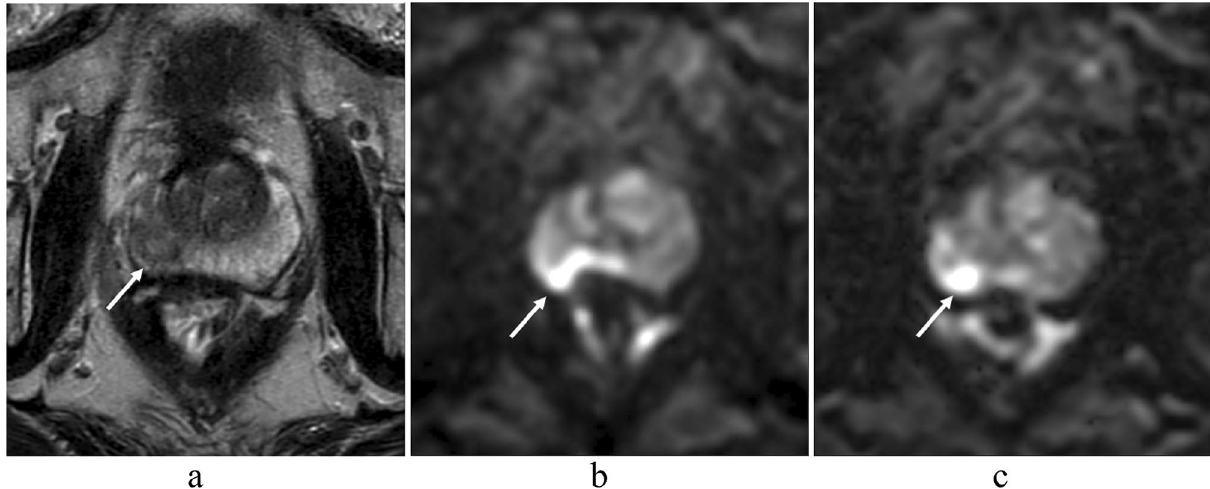
Figure 3. A 73-year-old man with prostate cancer (PSA level, 8.34 ng/mL; Gleason score, 3 + 3) in the right peripheral zone. A heterogeneous hypointense lesion with mass effect is seen on T2-weighted imaging ( a ) (arrow). A focal hyperintensity is depicted clearly on msEPI DWI ( c ) (arrow). Lesion clarity in ssEPI DWI ( b ) is impaired by distortion induced by rectal gas (arrow). However, SNR is higher in ssEPI DWI ( b ) than in msEPI DWI ( c ). PSA prostate-specific antigen, SNR signal-to-noise ratio, ssEPI single-shot echo-planar imaging, DWI diffusion-weighted imaging, msEPI multi-shot echo-planar imaging.